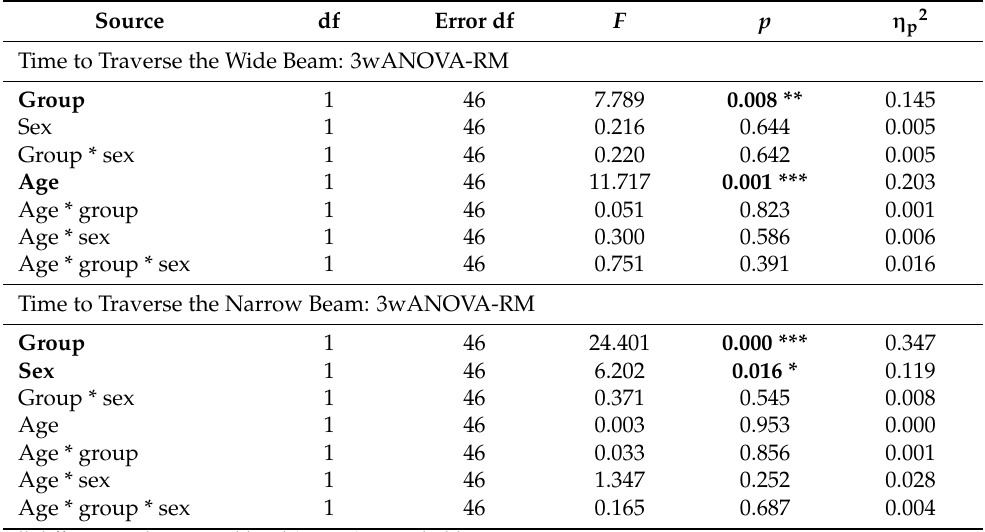
Table A6. Three-way ANOVA-RM table for the beam walking